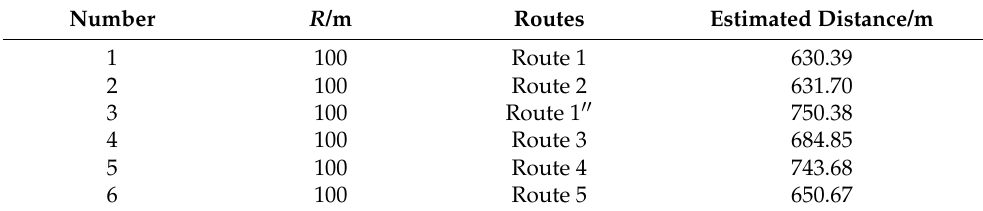
Table 2. The real data of different routes for the test points in Table 1.